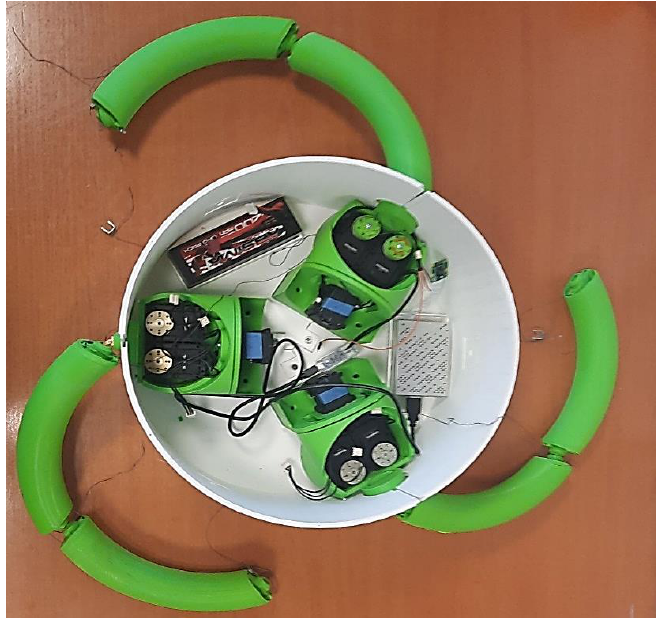
Figure 17. Full prototype assembly with the three motor units and the three limbs.